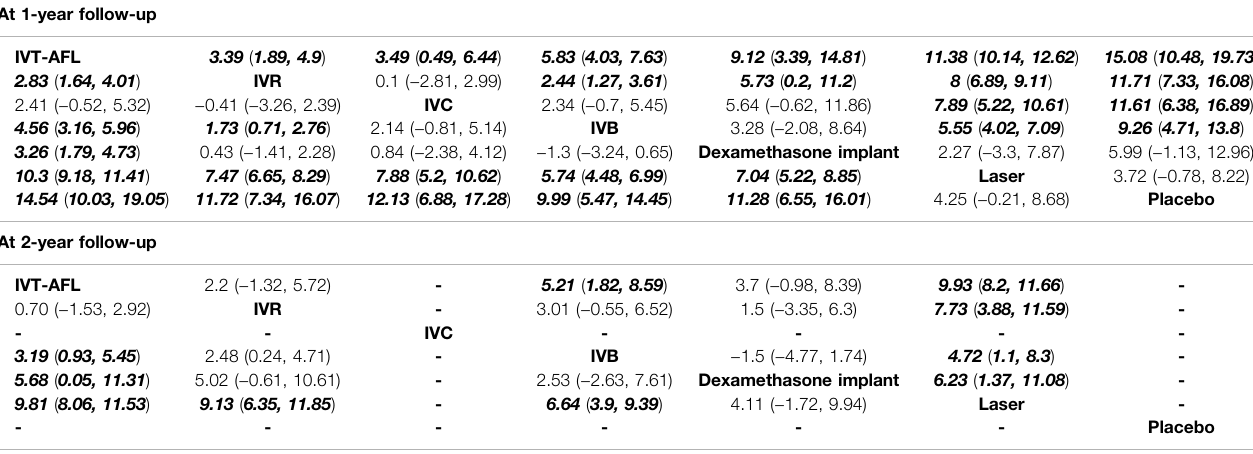
TABLE 1 | MDs with 95% CrIs of network meta-analysis for BCVA (ETDRS letters) mean change from baseline. At 1-year